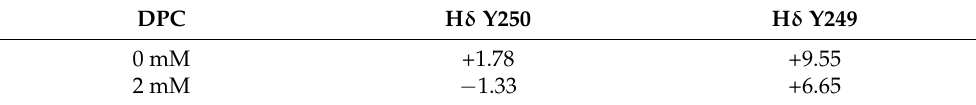
Table 1. Photo-CIDNP NMR intensity (calculated from integral values shown by Figures S9 and S10) of Y249 and Y250 for H δ from LytA 239–252 peptide in aqueous solution (D 2 O) for 0 and 2 mM DPC micelle concentration (298 K, pH = 3.0). Method B was followed (see Section 4).